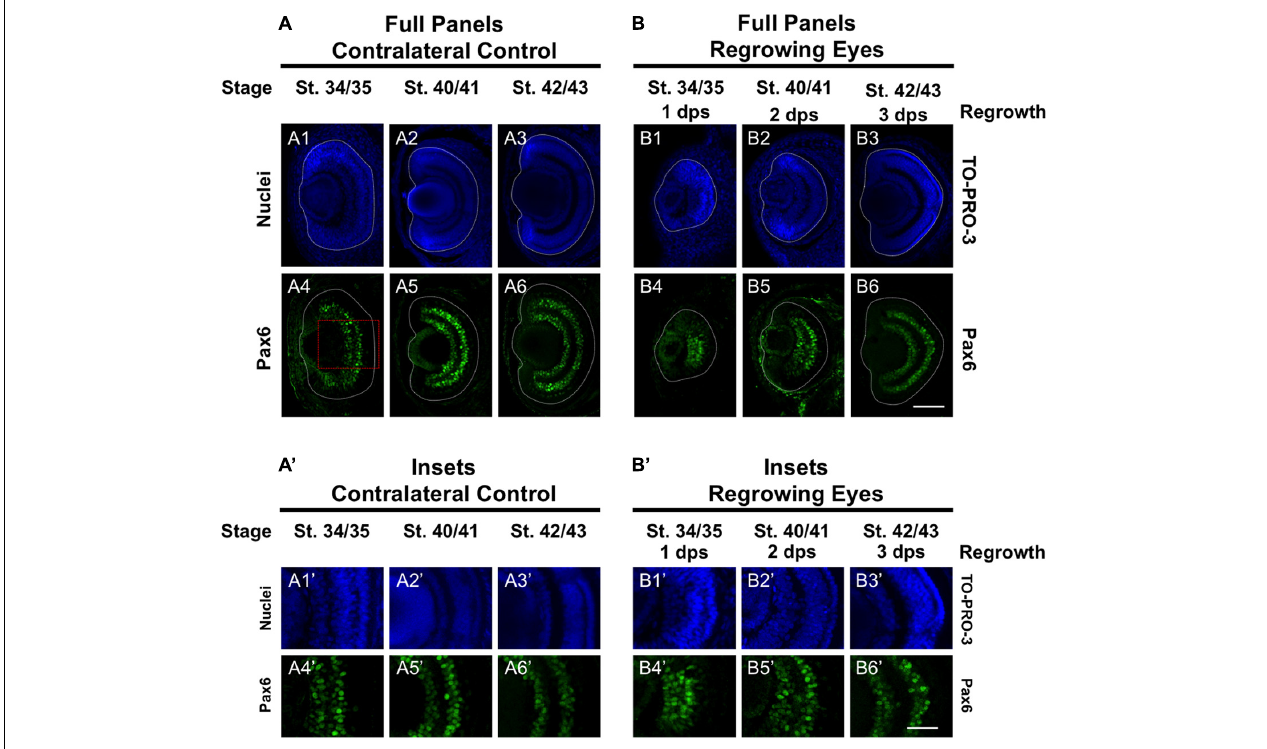
FIGURE 6 | Regrown eyes regain Pax6 patterning by 3 dps. Images shown are immunostained, transverse sections at three developmental timepoints corresponding to 1, 2, and 3 days post surgery (dps). (A,B) Pax6 expression in the regrowing eye is less organized at 1 dps but regains patterning similar to contralateral control eyes (unoperated) by 3 dps. White dashed lines delineate each regrowing eye. (A’,B’) Images shown in panels A’ and B’ correspond to the region shown in the inset box in panel A4 for the corresponding A or B panel at high magnification. Blue color indicates nuclear staining (TO-PRO-3). Green color indicates anti-Pax6 signal. Sample sizes: 1 day, n = 5; 2 days, n = 7; and 3 days, n = 6. (A,B, A’,B’) Up = dorsal, down = ventral, lens is on the left. Scale bar: A,B = 100 µ m and A’,B’ = 50 µ